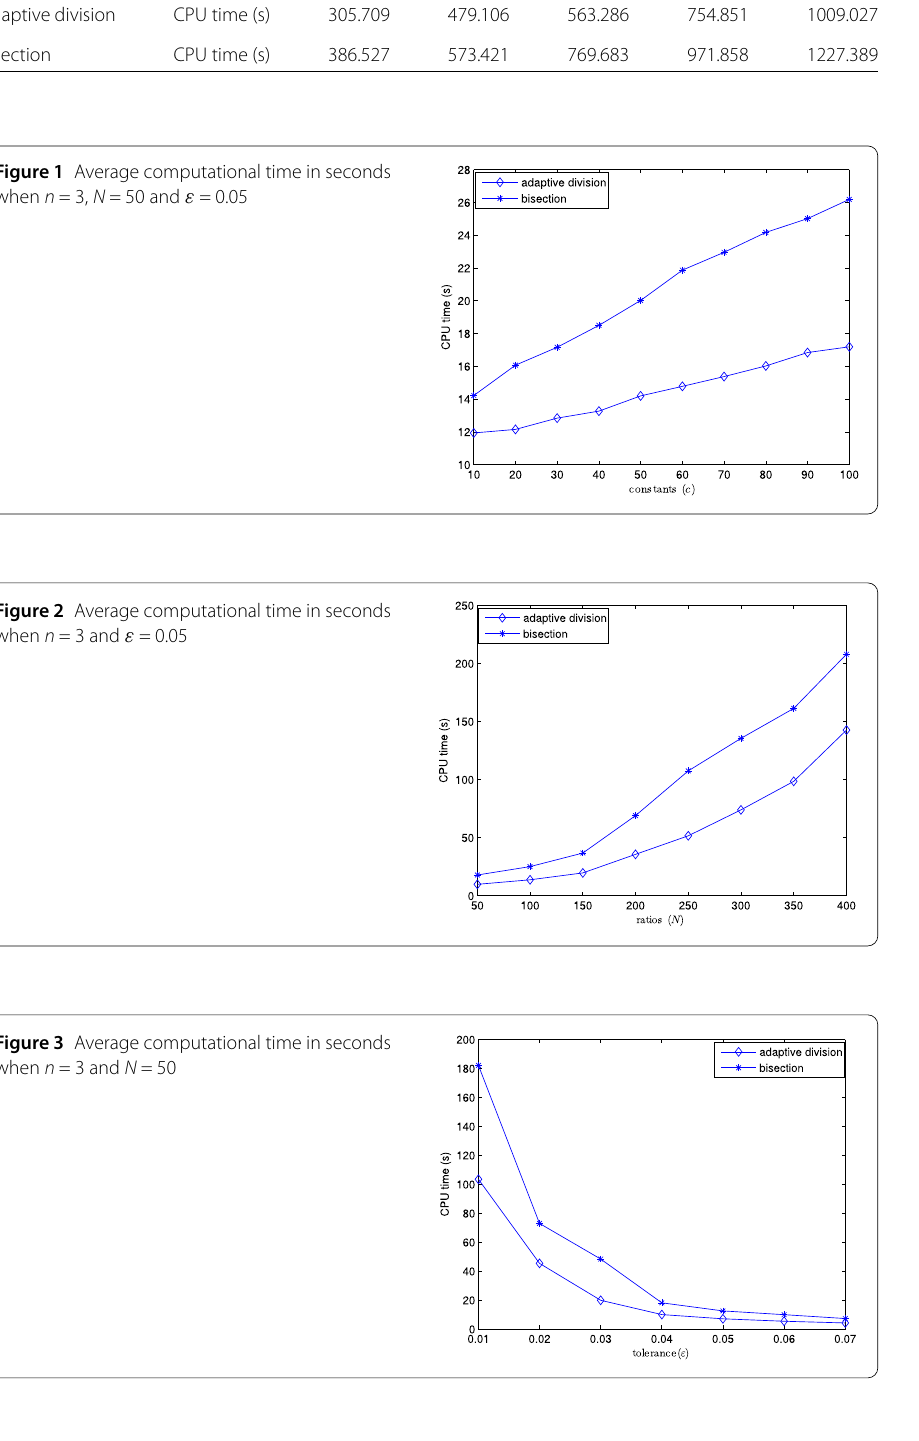
Table 2 Average performances of adaptive division and bisection when n = 3 and ε = 0.05